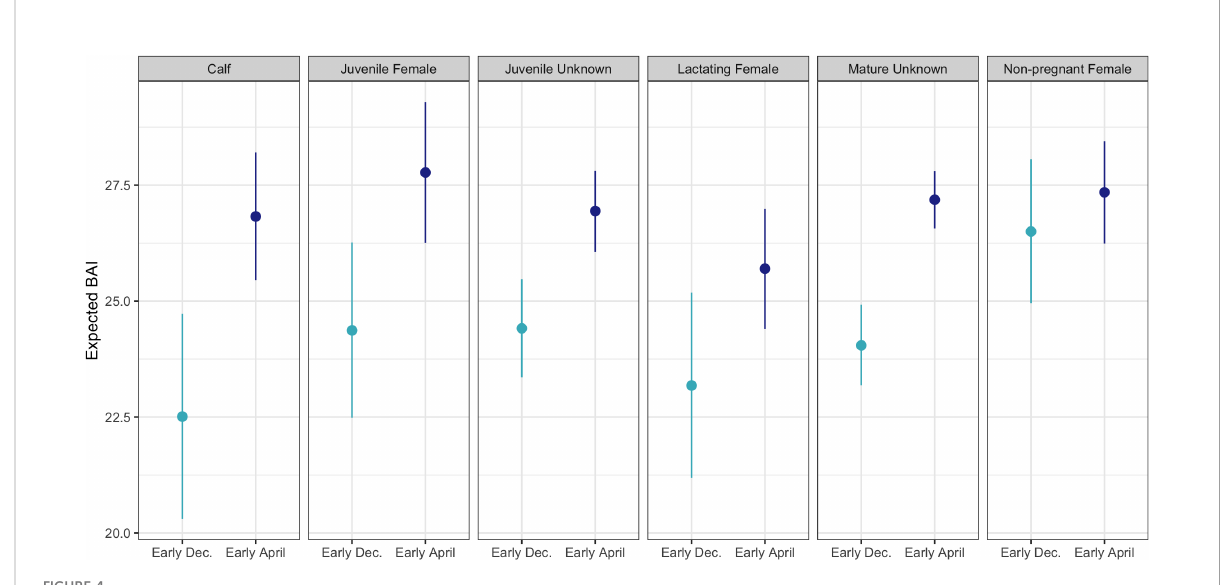
FIGURE 4 The expected Body Area Index (BAI) for the average whale in each reproductive class for early (beginning of December, lighter blue ) and late (beginning of April, darker blue ) season. Each point represents the mean expected BAI for that reproductive class, and the bars represent the 95% highest posterior density (HPD)